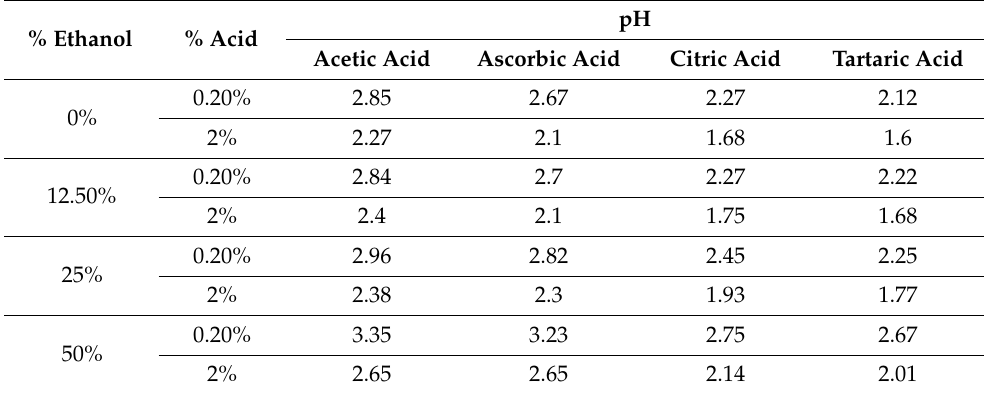
Table 1. The pH of mixtures of chicory powder and different extraction solvents.